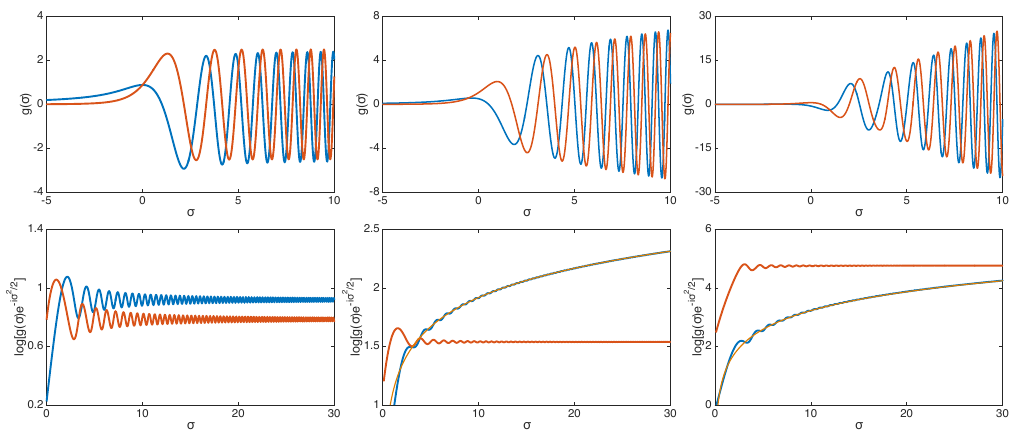
Figure 1: Top row: real (blue) and imaginary (red) parts of the scaling function g ( σ ) = ( t / m ) η 2 / 2 G ( x , t ) , obtained by solving numerically the ODE, see Appendix C; (left column) free fermions η = 1, (central column) η = 1.2, (right column) η = corresponds to ν = 1 / 3 FQHE case. Bottom row: the logarithm of the scaling function log [ g ( σ ) e − i σ 2 / 2 ] for the same values of η , compared for η = 1.2, η = totic power law dependence Eq. (28) (orange line). The power law follows from the mobile impurity asymptotics [ 5 ] we give in Eqn. (28) for G ( x , t ) , which imply for σ = g ( σ ) ∼ σ η 2 − 1 − 2 ( η − 1 ) 2 e i σ 2 / 2 , and for σ < 0, g ( σ ) is asymptotic to the Luttinger